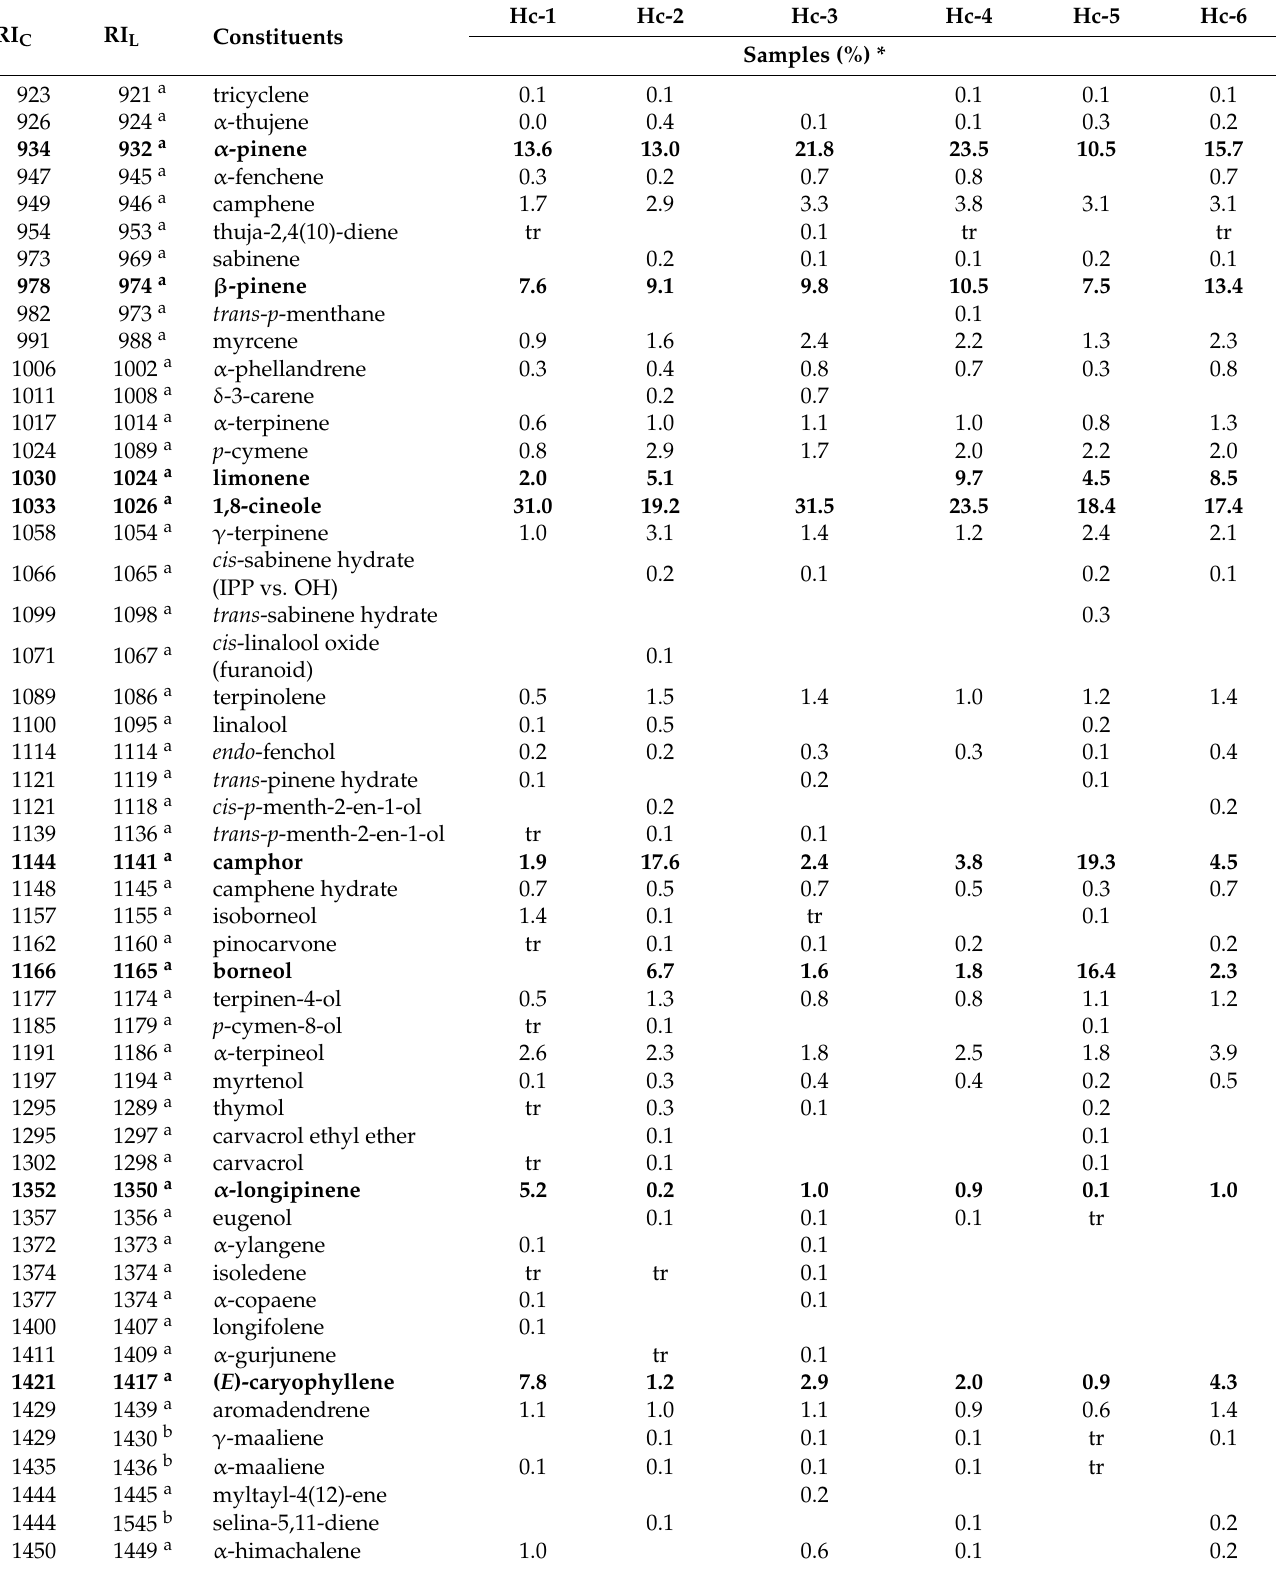
Table 1. Yield and composition of essential oils from Hyptis crenata